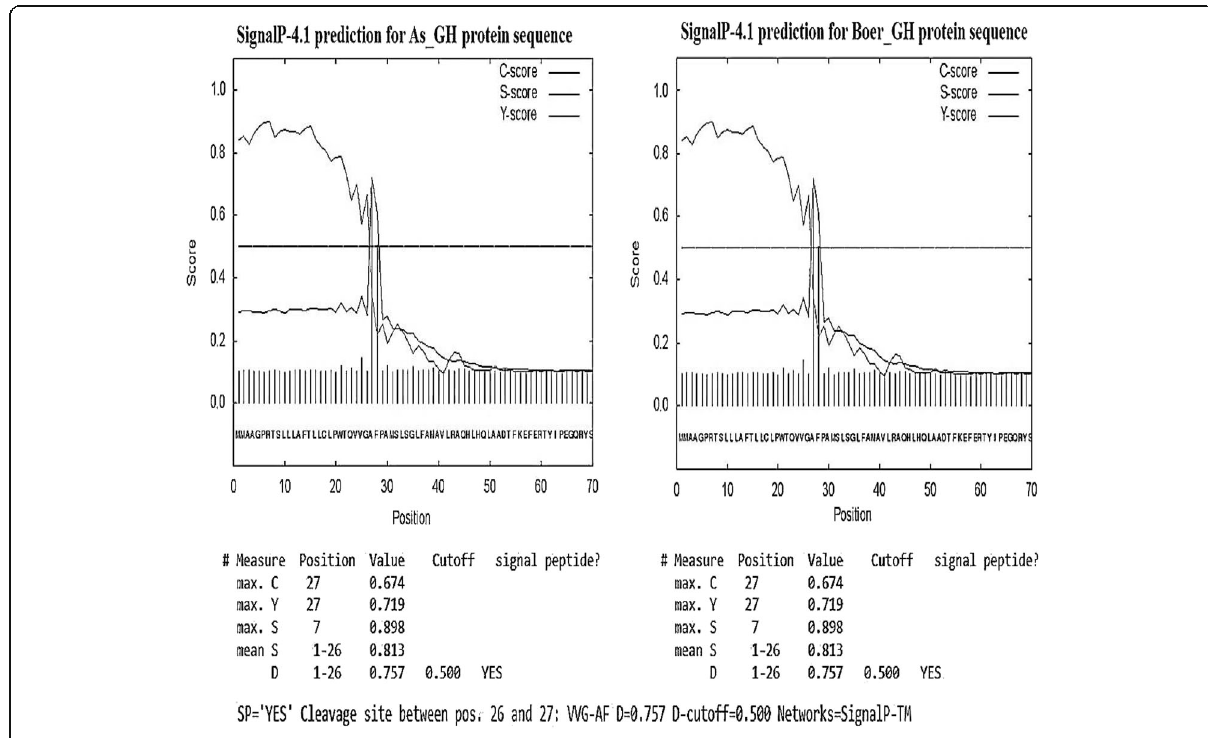
Fig. 9 The predicted cleavage site of signal peptide in As_GH and Bo_GH protein